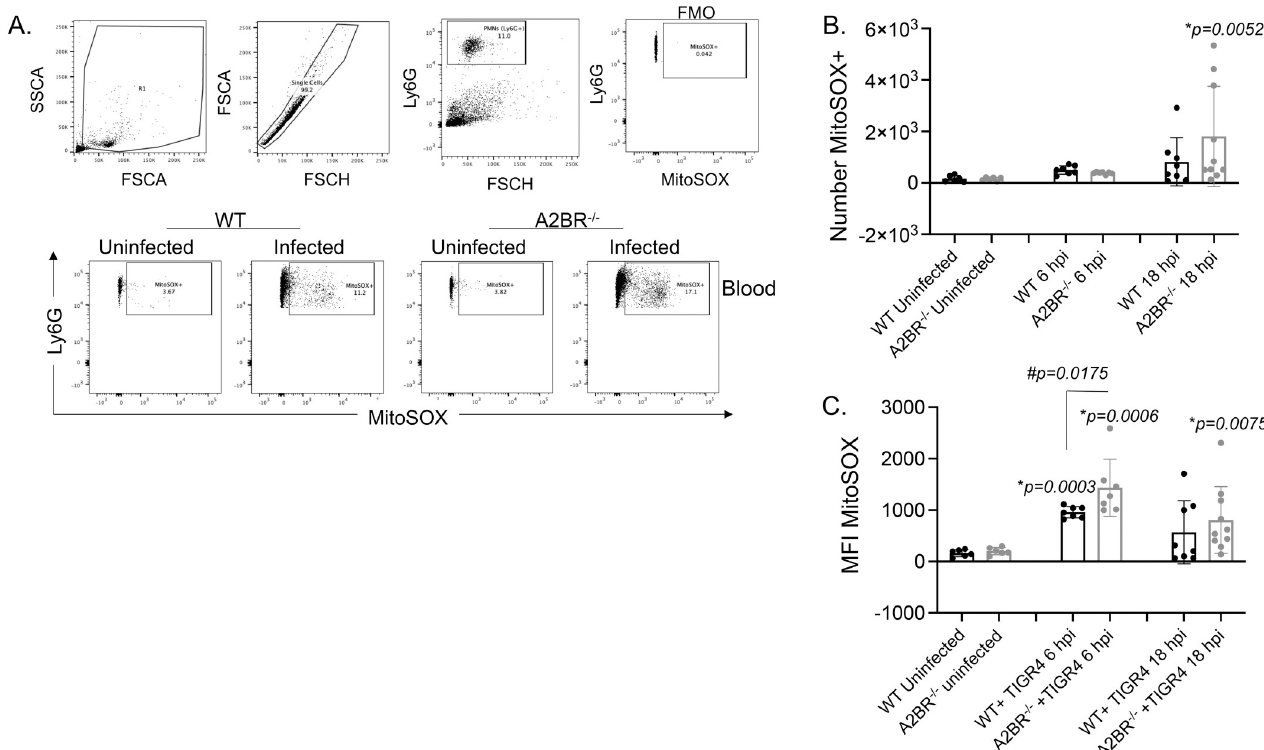
Fig 9. Mitochondrial ROS are produced in circulating PMNs in response to systemic infection. A2BR -/- (light grey) mice were infected with S . pneumoniae TIGR4 intra-peritoneally. At 6 and 18 hours following challenge, the number (B) of mitochondrial ROS producing PMNs (Ly6G+) and (C) the amount of mitochondrial ROS produced (MFI MitoSOX) by PMNs in the circulation were determined by flow cytometry using MitoSOX (see Materials and Methods). (A) Gating strategy is shown including controls (FMO indicates absence of MitSOX dye only). (B-C) Data are pooled from four separate experiments and each dot represents an individual mouse. � indicates significant differences from uninfected controls for each mouse strain as determined by Kruskal-Wallis test.